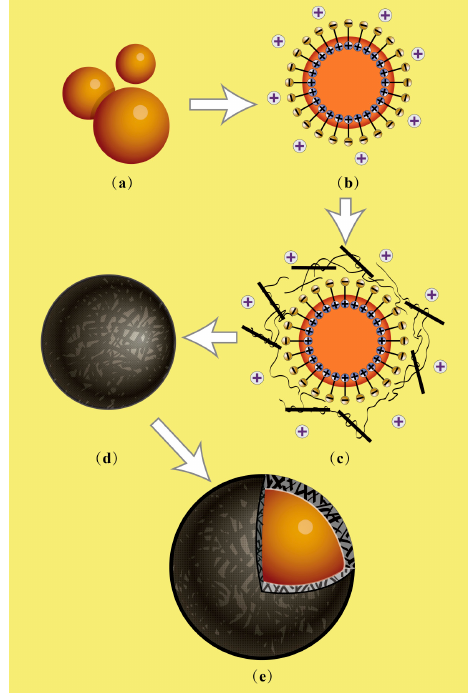
Figure 1. Illustration of microcapsules containing phase change materials (microPCMs) fabricated by a self-assembled process, ( a , b ) paraffin was emulsified by styrene maleic anhydride (SMA) molecules; ( c ) the mixture of melamine-formaldehyde (MMF) prepolymer and graphene added dropwise, MMF prepolymer and graphene absorbed on core droplets by electric charge; ( d ) microcapsules formed through a polymerization process; and ( e ) the state of graphene in the shell.